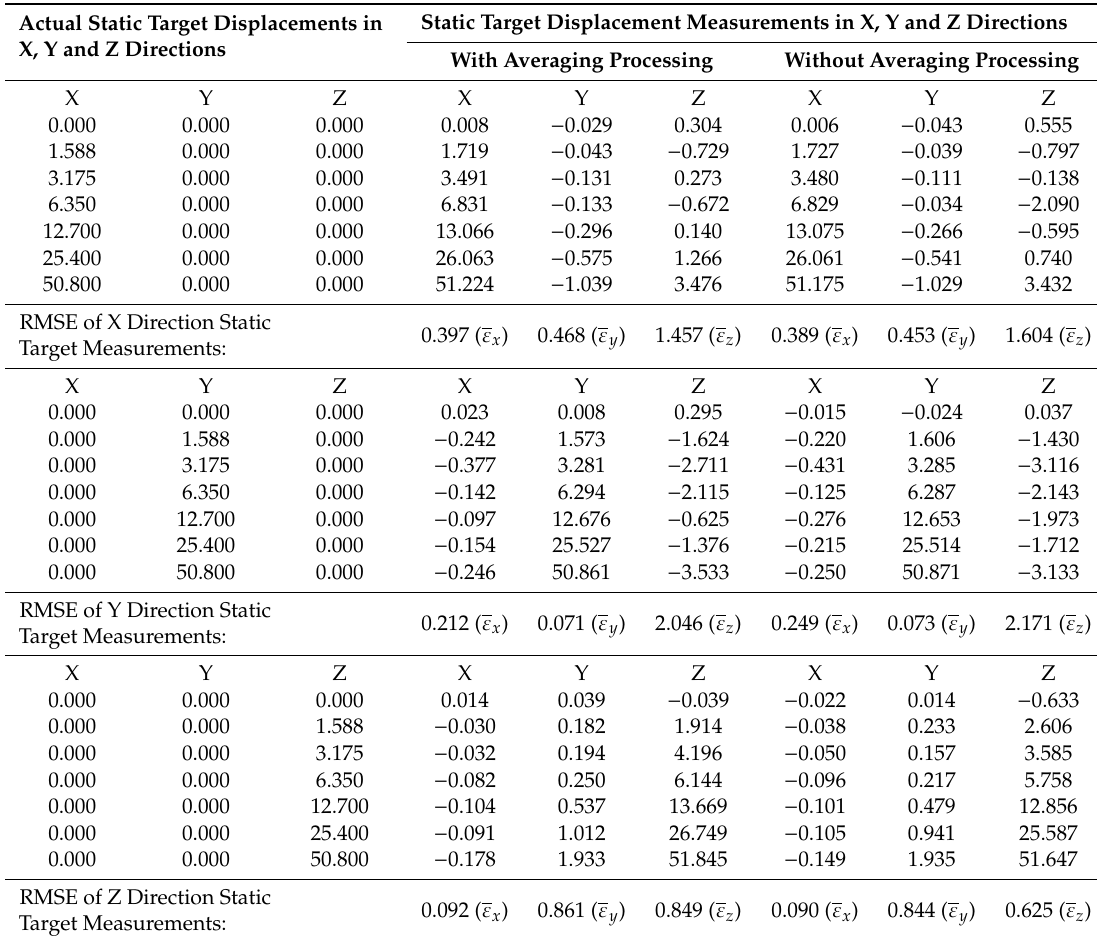
Table 2. Comparative analysis of applying averaging processing to the synthetic static target displacements using a stationary camera